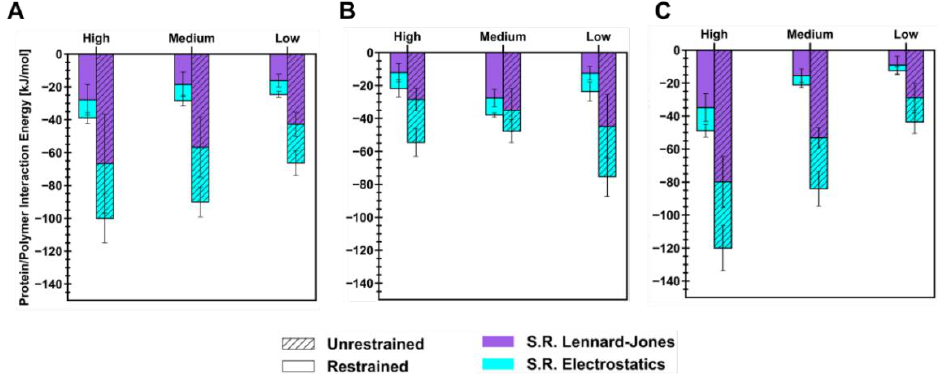
Figure 5. Protein – polymer short-range interaction energies for each level of extension for ( A ) PLGA/ID2S, ( B ) PEG/ID2S, and ( C ) PLGA-PEG/ID2S. For each stacked bar, the sum of Lennard– Jones and electrostatic interaction energies equal the total interaction energy. Mean and its standard error (SE) came from first averaging interaction energies across oligomers (n = 3/trial) then across simulation trials (n = 7).